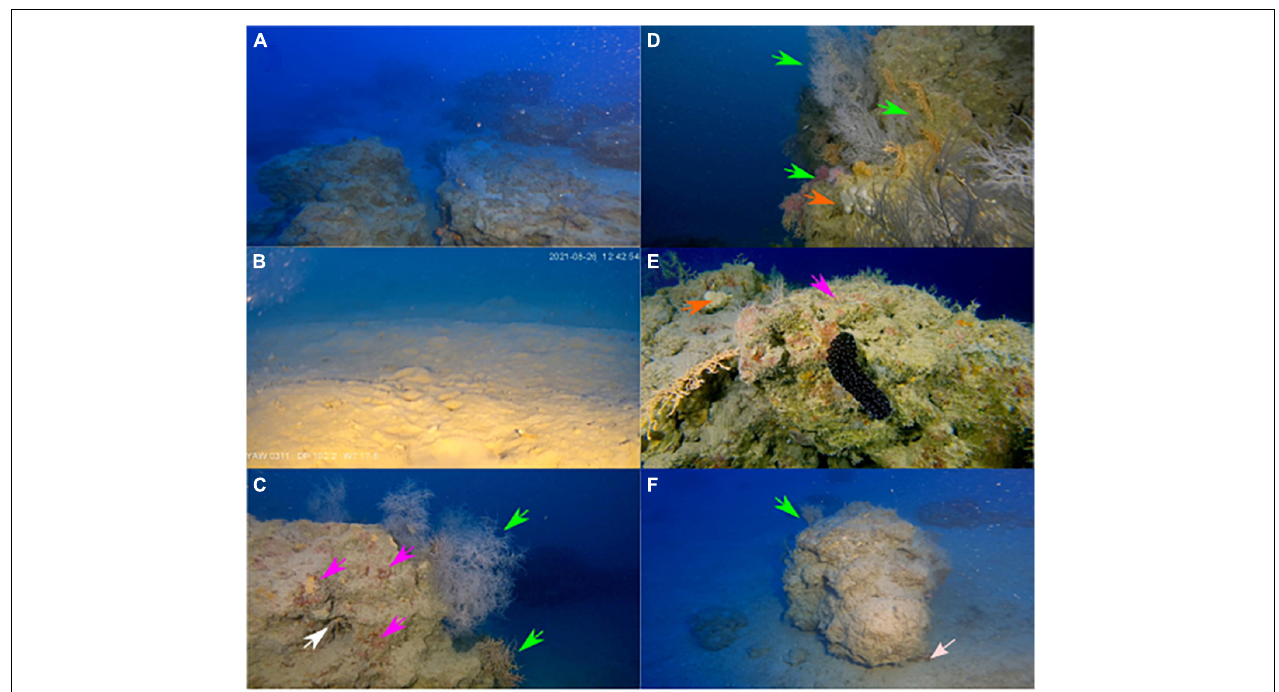
FIGURE 7 | Imagery from mounds at 90 mbpsl. (A) Rock outcrops in mounds from in the southern part of the study area; (B) sediments adjacent to a mound in the southern part of the study area; (C) rock outcrop from a mound in the southern part of the study area with red alga (magenta arrows), Anthipatarians (green arrows) and sea urchin (white arrow); (D) rock outcrop from a mound in the southern part of the study area with Anthipatarians and gorgonian (green arrows, white and orange specimens, respectively) and sponges (orange arrow); (E) rock outcrop from a mound in the southern part of the study area with an Holoturia, note also sponges (orange arrow) and red alga (magenta arrows). (F) Rock outcrop from a mound in the southern part of the study area with a notch at the base (pinkish-white